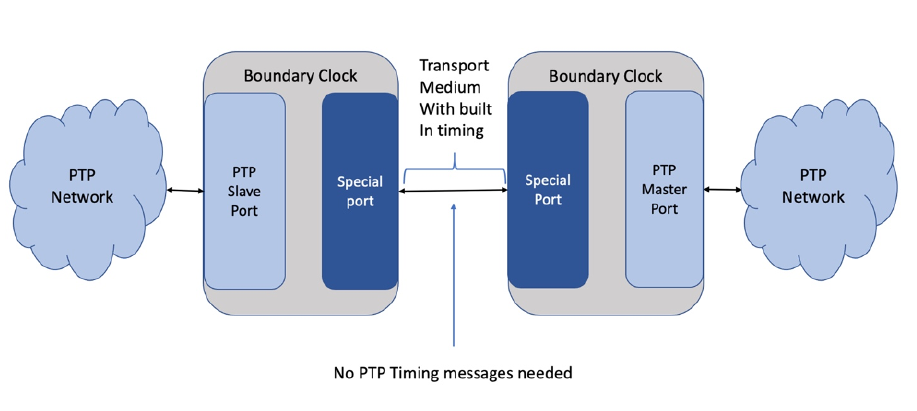
Figure 8. The PTP is transferred across a transport media that has a built-in timing mechanism by using special ports on boundary